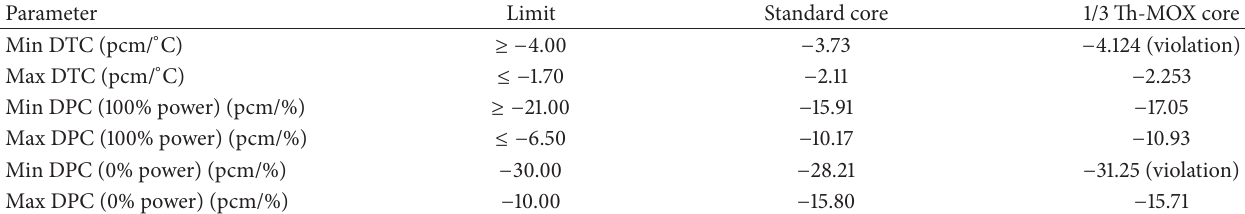
Table 3: The reactivity feedback DTC and DPC.